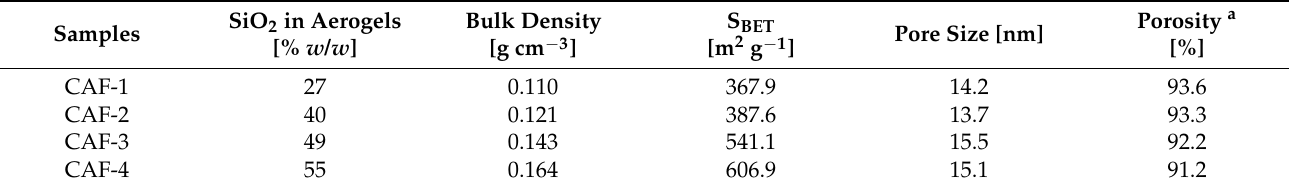
Figure 4. Nitrogen adsorption–desorption isotherms ( a ) and pore size distribution ( b ) of CAFs. Table 1. Physical properties of CAFs.